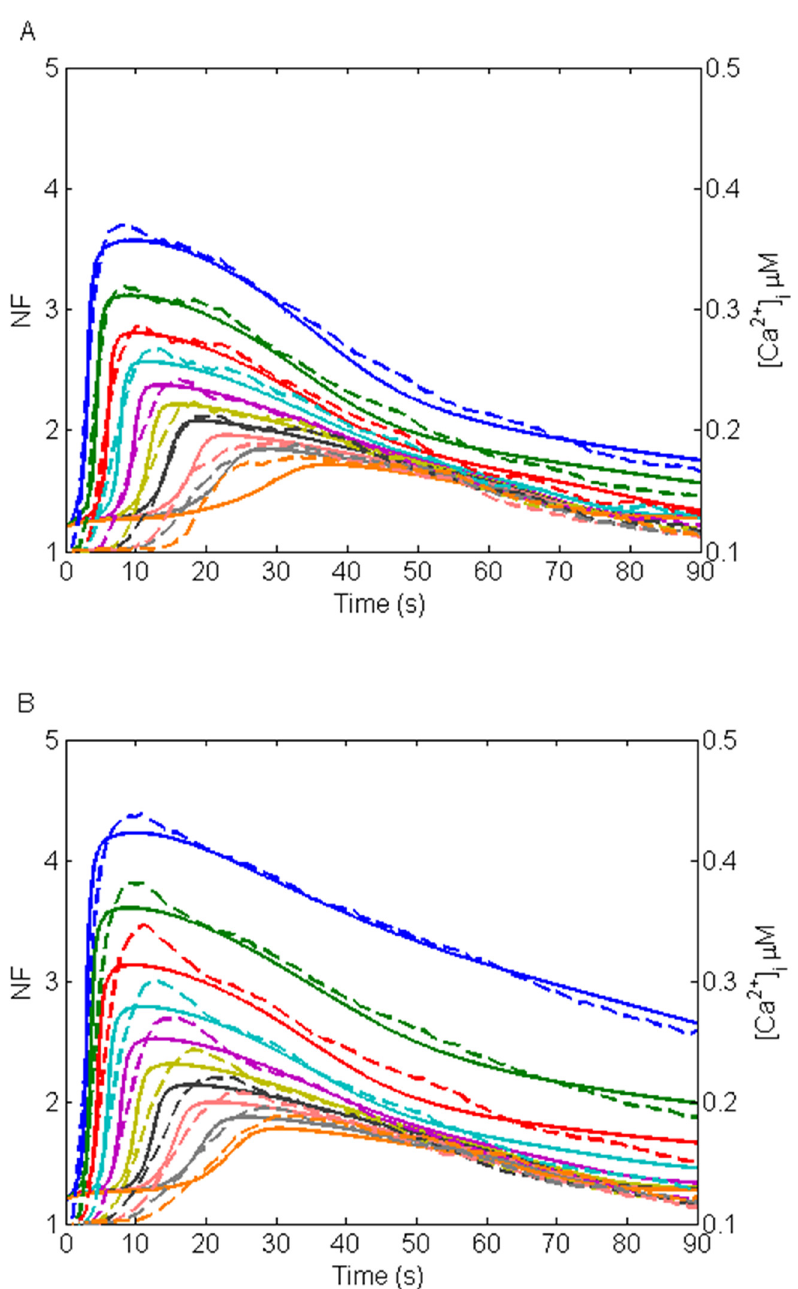
Fig 5. Fittings of the model to the experimental data. (A) GA-treated, and (B) control data sets with dashed lines representing the data in dimensionless NF units and solid lines representing the model simulations with arbitrary units representing [Ca 2+ ] i in μ M concentrations. The uppermost curve pair (blue) represents NB1, the second uppermost NB2 (green), followed by NB3 (red), NB4 (light blue), NB5 (purple), NB6 (yellow), NB7 (black), NB8 (light red), NB9 (grey), and NB10